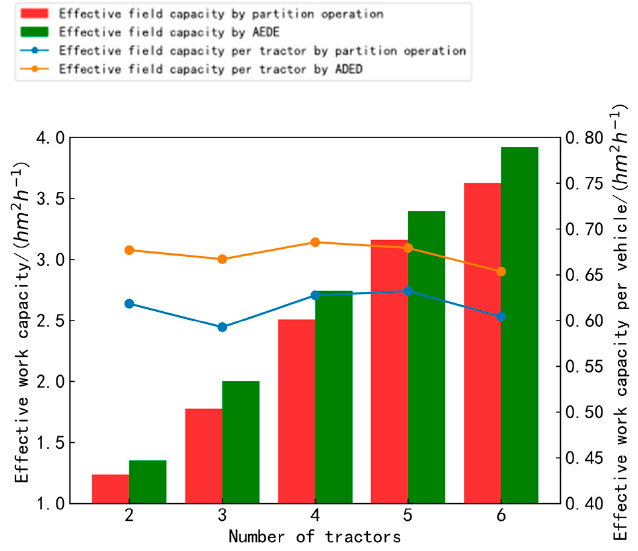
Figure 7. Comparison of effective work capacity and effective work capacity per vehicle.